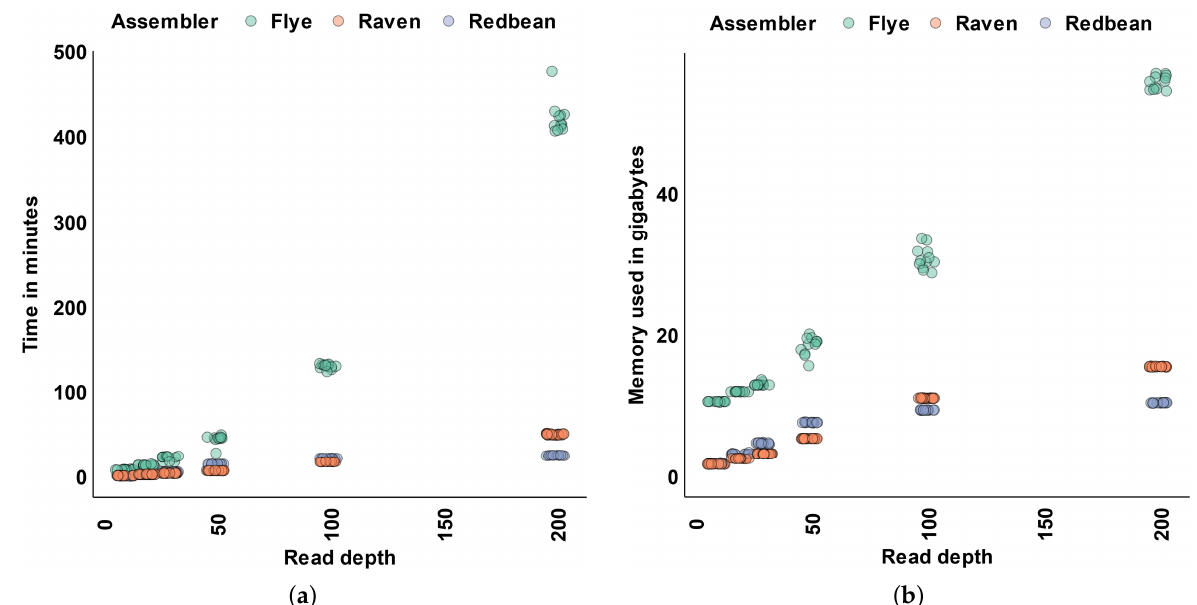
Figure 5. Time and memory usage of each assembler. ( a ) Time usage. ( b ) Memory usage. Across all read depths, Raven and Redbean used less memory than Flye to build an assembly (Figure 5b). At read depths under 100 × , Raven used less memory than